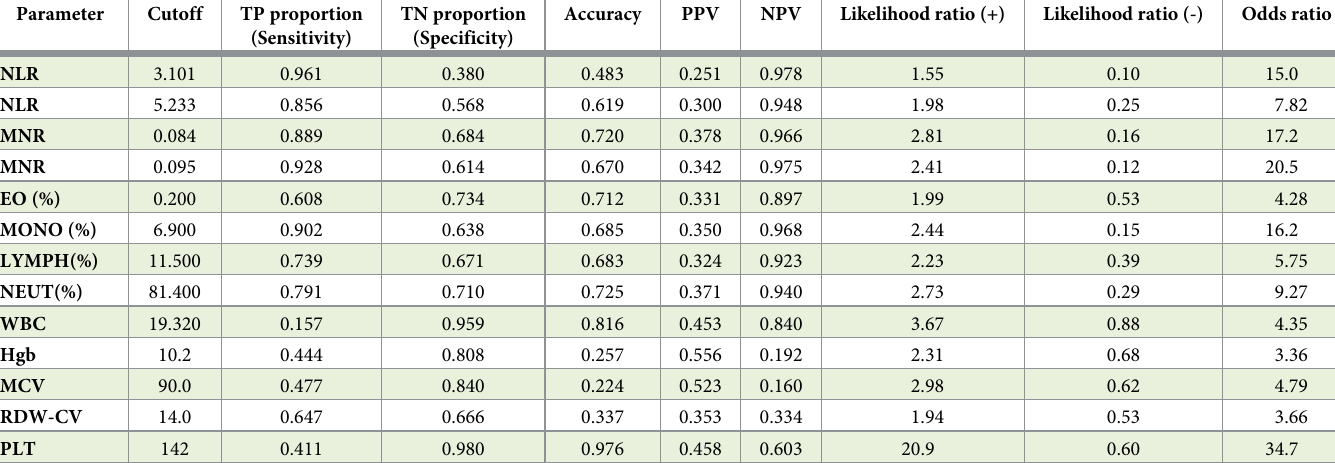
Table 5. Prognostic evaluation of the best parameters to show mortality from disease.